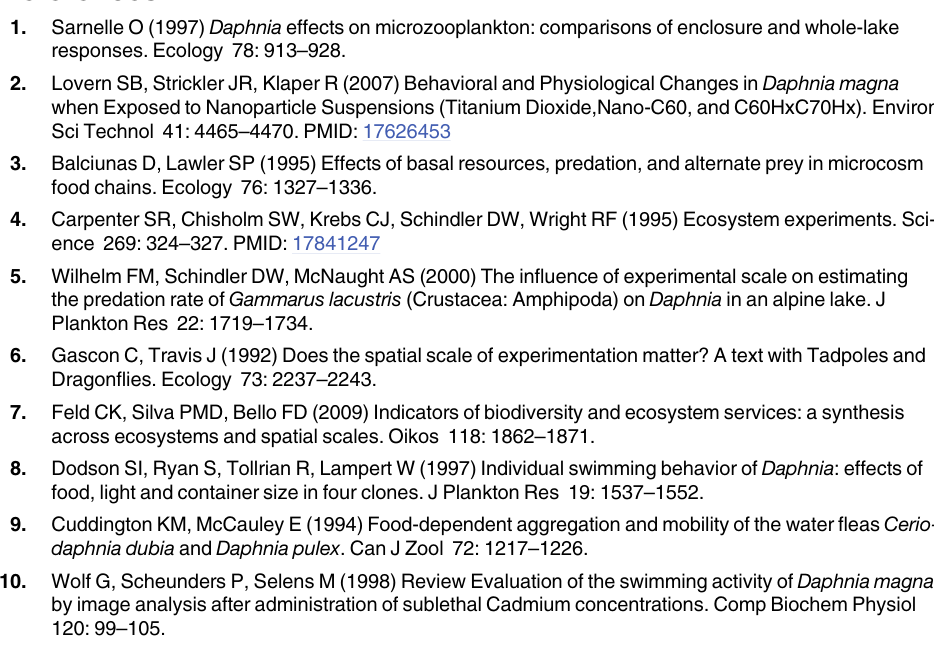
S1 Table. Dissolved oxygen concentration (means ± s. d, n = 6) in different plankton sys- tems under different microcosm conditions. SL: short height and large diameter; SM: short height and medium diameter; MM: medium height and medium diameter; TM: tall height and medium diameter; TS: tall height and small diameter. No significant difference in the concen- tration was found among treatments at the 0.05 significance level. S2 Table. Linear regressions between the ratio of chamber height to base diameter and spe- cific swimming activity in two Scenedesmus quadricauda -grazer systems. S3 Table. Linear regressions between the ratio of chamber height to base diameter and spe- cific swimming activity in two Chlorella vulgaris -grazer